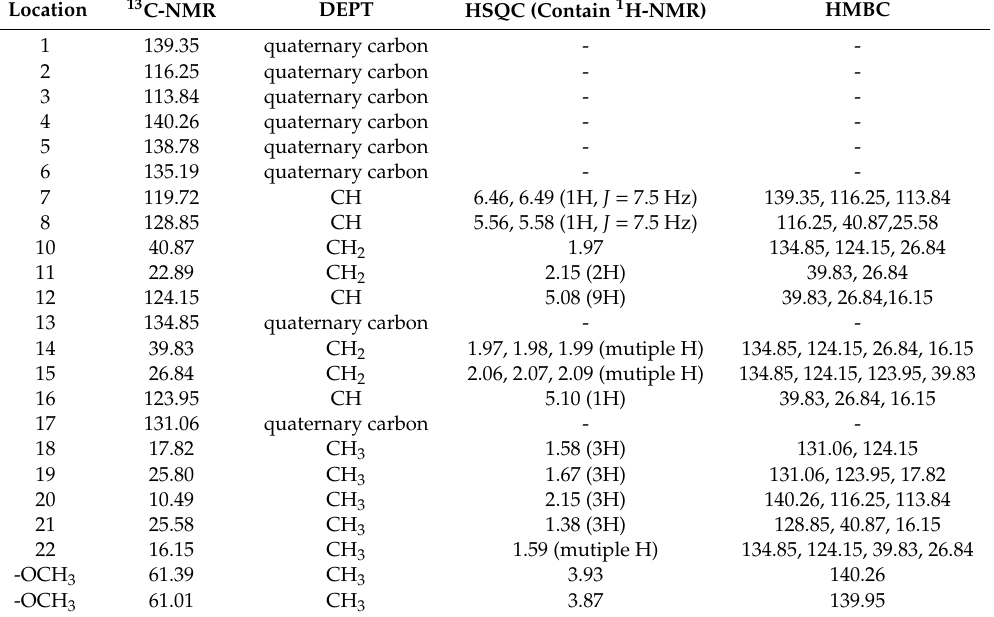
Table 1. C-attribution in the spectrogram of Impurity